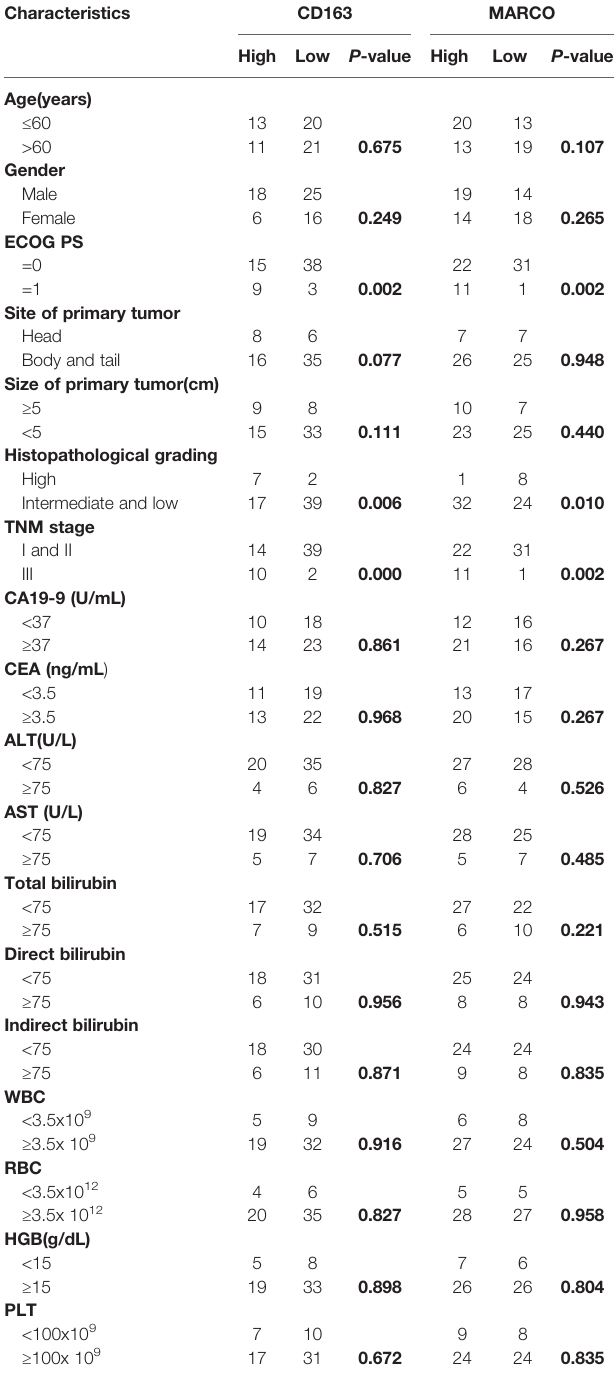
TABLE 2 | Correlation of clinicopathologic characteristics with CD163 and MARCO expression.